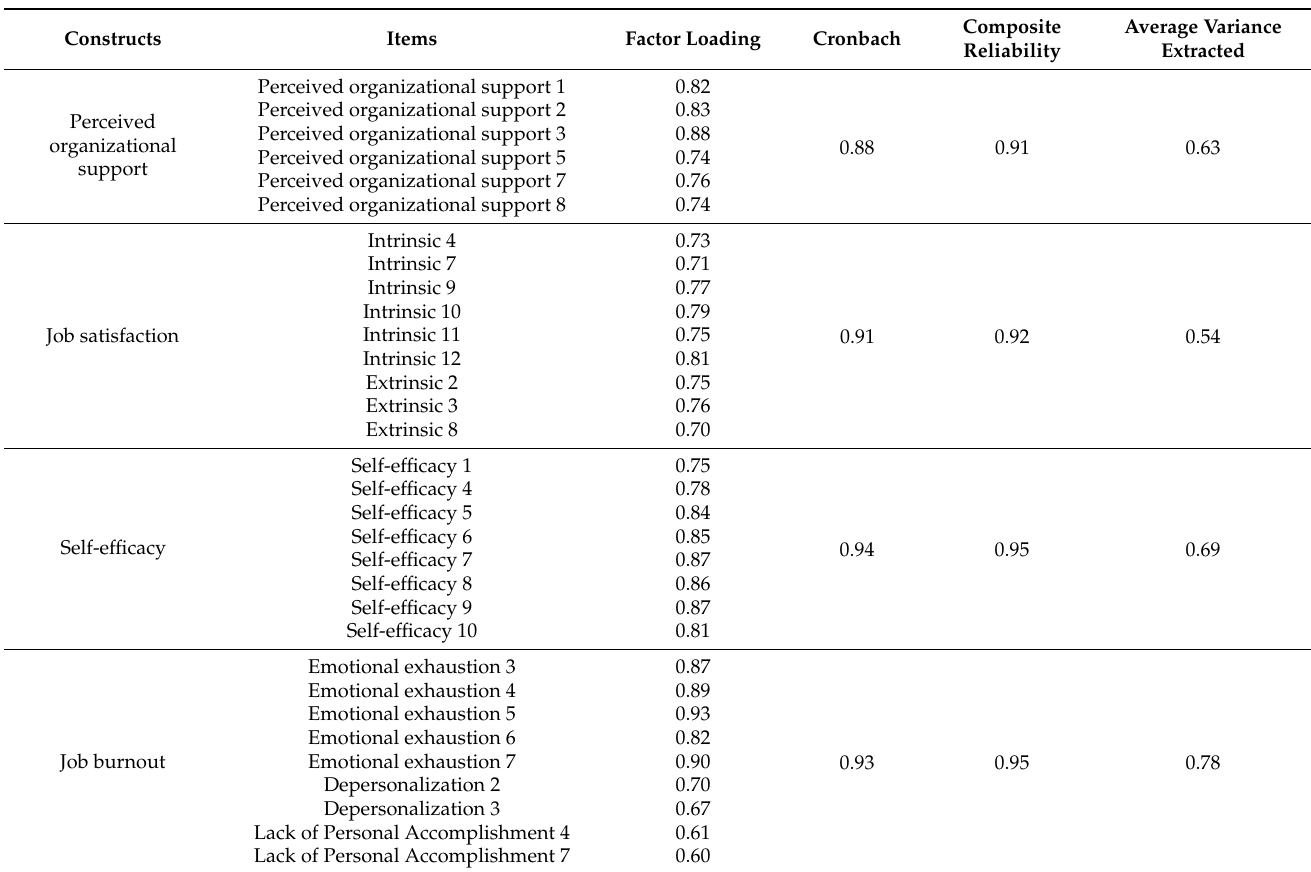
Table 5. Factor loading, Cronbach’s alpha, composite reliability, and average variance of the items extracted from the